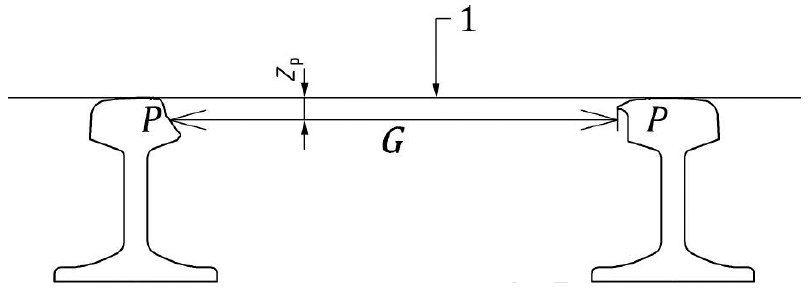
Figure 17. Track gauge in case of a used track (MSZ EN 13848-1,